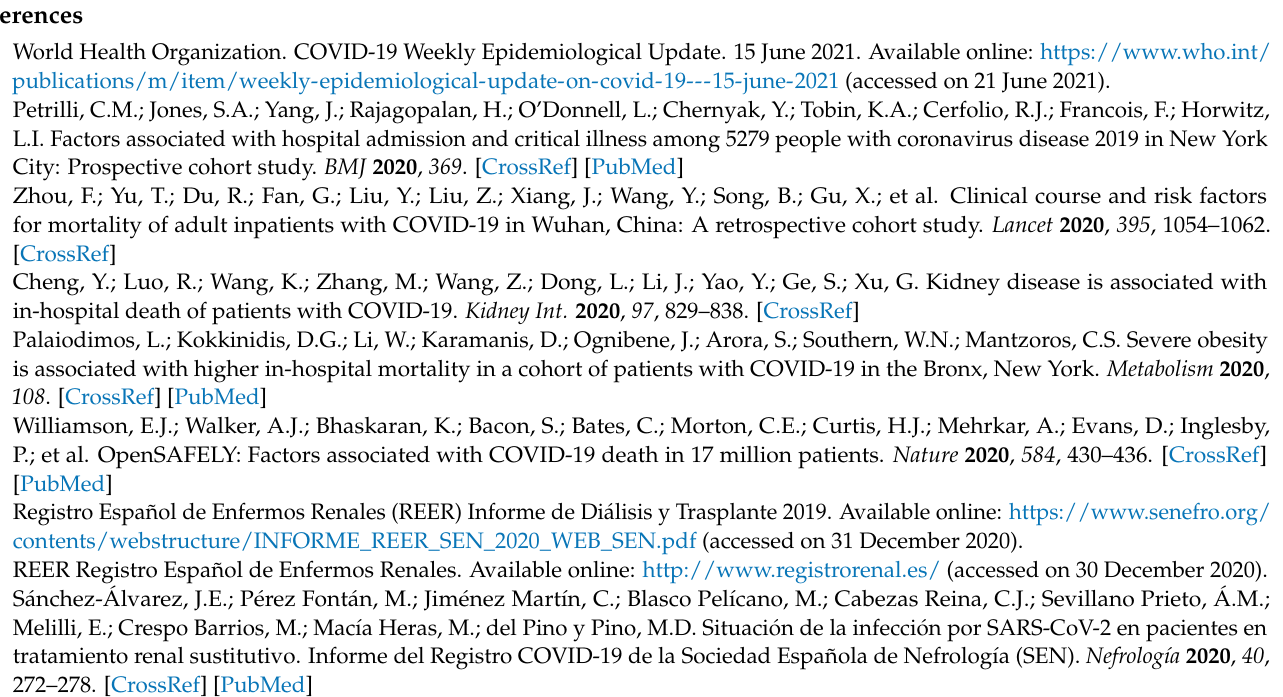
Figure S1: ROC curve depicting age as a predictor of mortality in elderly haemodialysis patients affected by